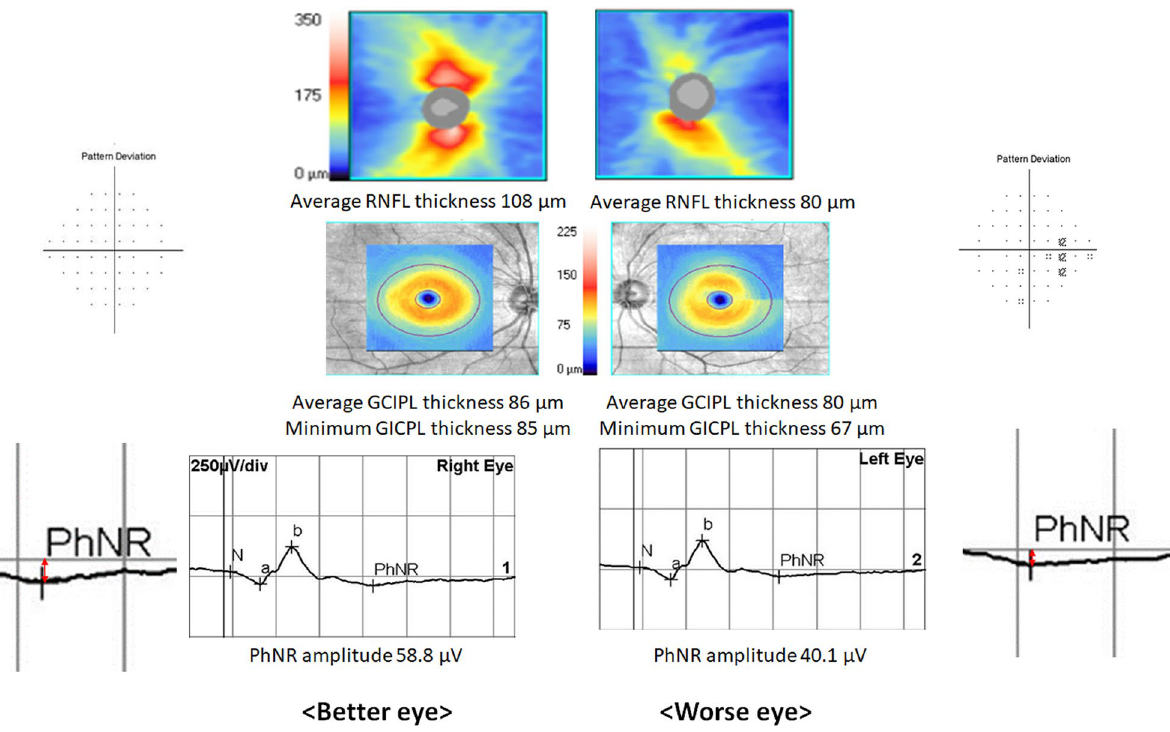
Figure 3. Representative case. A 44-year-old patient had thinner retinal nerve fiber layer and ganglion cell- inner plexiform layer in his left eye (80 µm, 67 µm) compared to his right eye (86 µm, 85 µm). PhNR amplitude was decreased in his left eye (40.1 µV) compared to his right eye (58.8